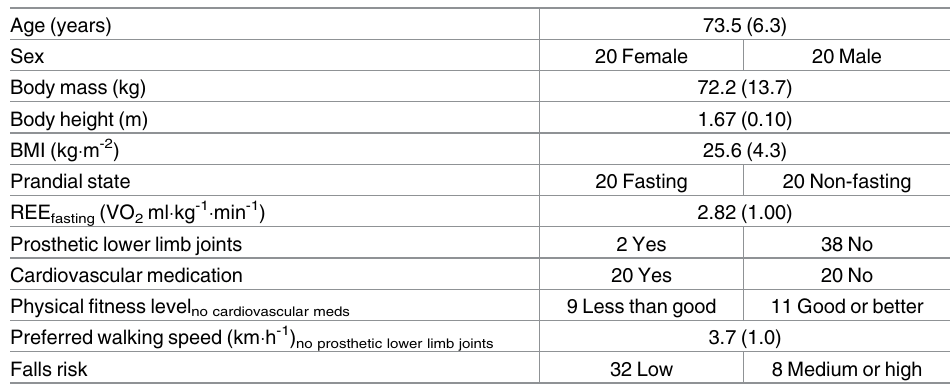
Table 1. Study sample